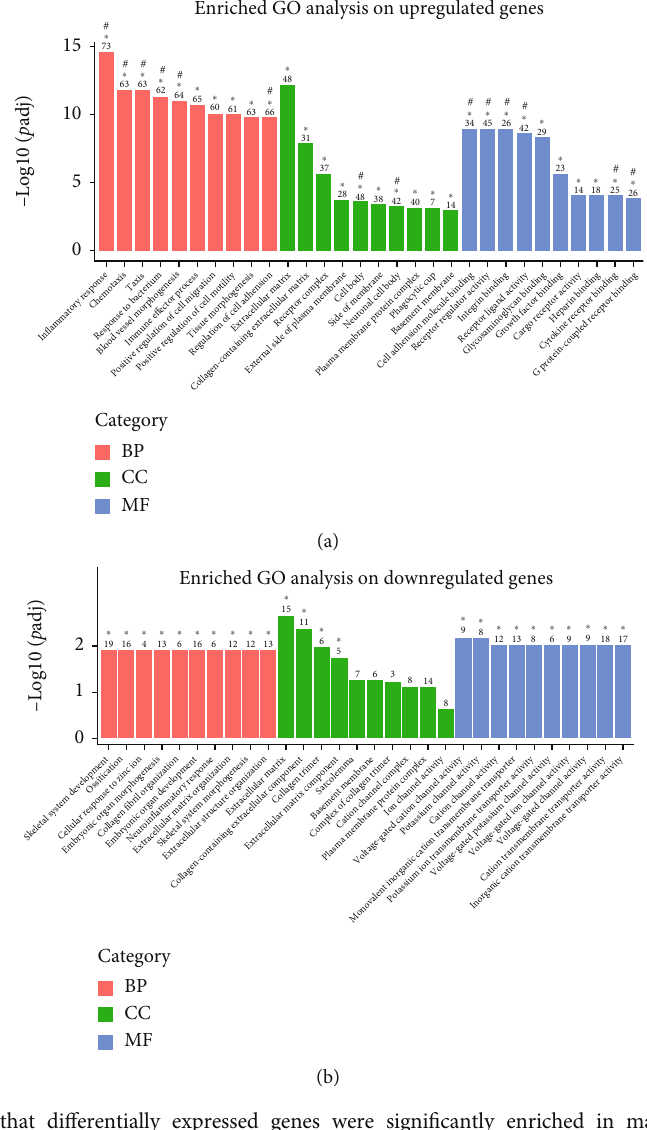
Figure 2: GO analysis found that di ff erentially expressed genes were signi fi cantly enriched in many biological activities, such as in fl ammatory response, blood vessel morphogenesis, and immune e ff ector process. CX3CL1 was involved in in fl ammatory response, receptor regulator activity, etc. Only top 10 terms in BP, CC and MF were presented. “ ∗ ” indicates a p : adj < 0 : 05 . “ # ” indicates that CX3CL1 was involved in the process. BP: biological process; CC: cell component; MF: molecular